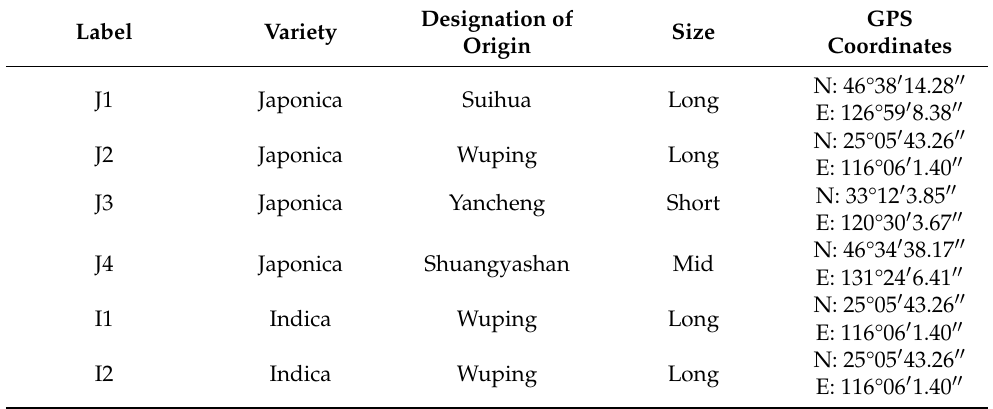
Table 1. Types of rice.